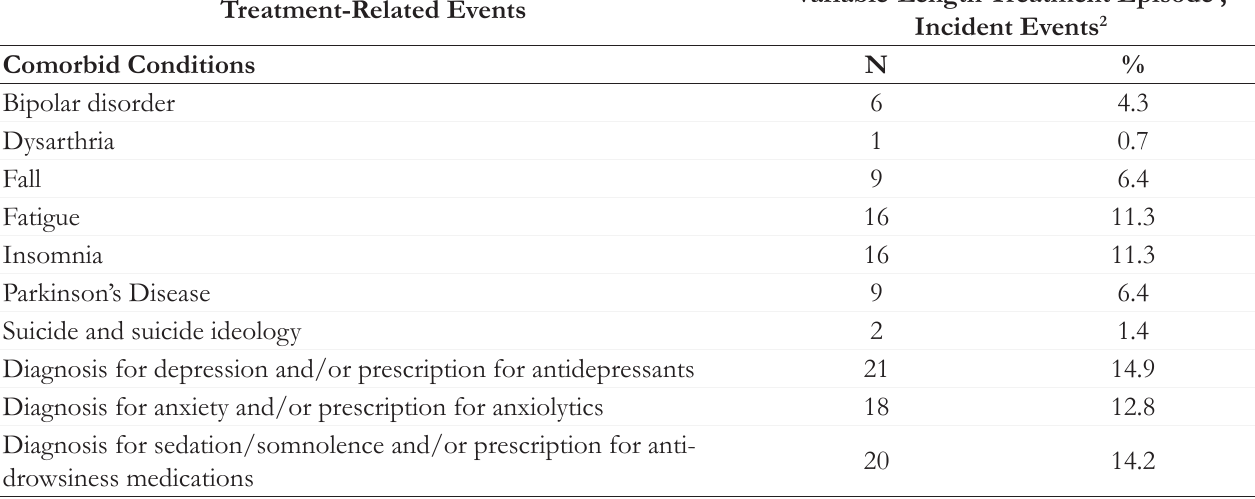
Variable-Length Treatment Episode 1